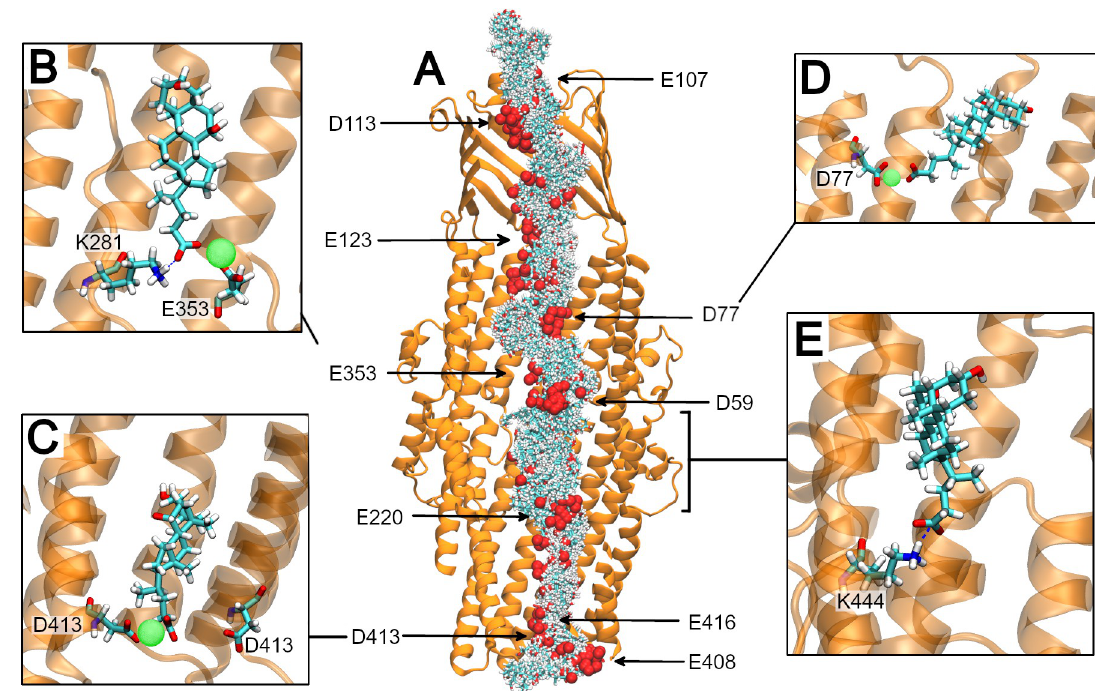
Fig 11. Translocation of CDCA through CmeC. (A) Cutaway of CmeC (orange New Cartoon representation) with every 5 th frame for CDCA (licorice, coloured by atom name, with carboxylate oxygen atoms shown as spheres) overlaid from one representative SMD simulation. CDCA displays orientation preference in several regions, generally when close to acidic lining residues. (B) A snapshot from a steered MD simulation. CDCA can coordinate calcium ions that are bound to acidic residues within the CmeC channel. They can simultaneously hydrogen bond to nearby basic residues, those these interactions are most commonly transient. (C) A snapshot from an equilibrium simulation. CDCA coordinates a calcium ion bound at the periplasmic entrance. This interaction with the tightly bound calcium is much longer-lived than interaction with bound calcium ions at wider points in the channel. (D) A snapshot from a steered MD simulation. CDCA coordinates an aspartate-bound calcium as it translocates. (E) A snapshot from an equilibrium simulation. In this replicate CDCA did not coordinate a calcium ion, and instead formed a salt bridge with K444 multiple times, with an average lifetime of 17 ns.